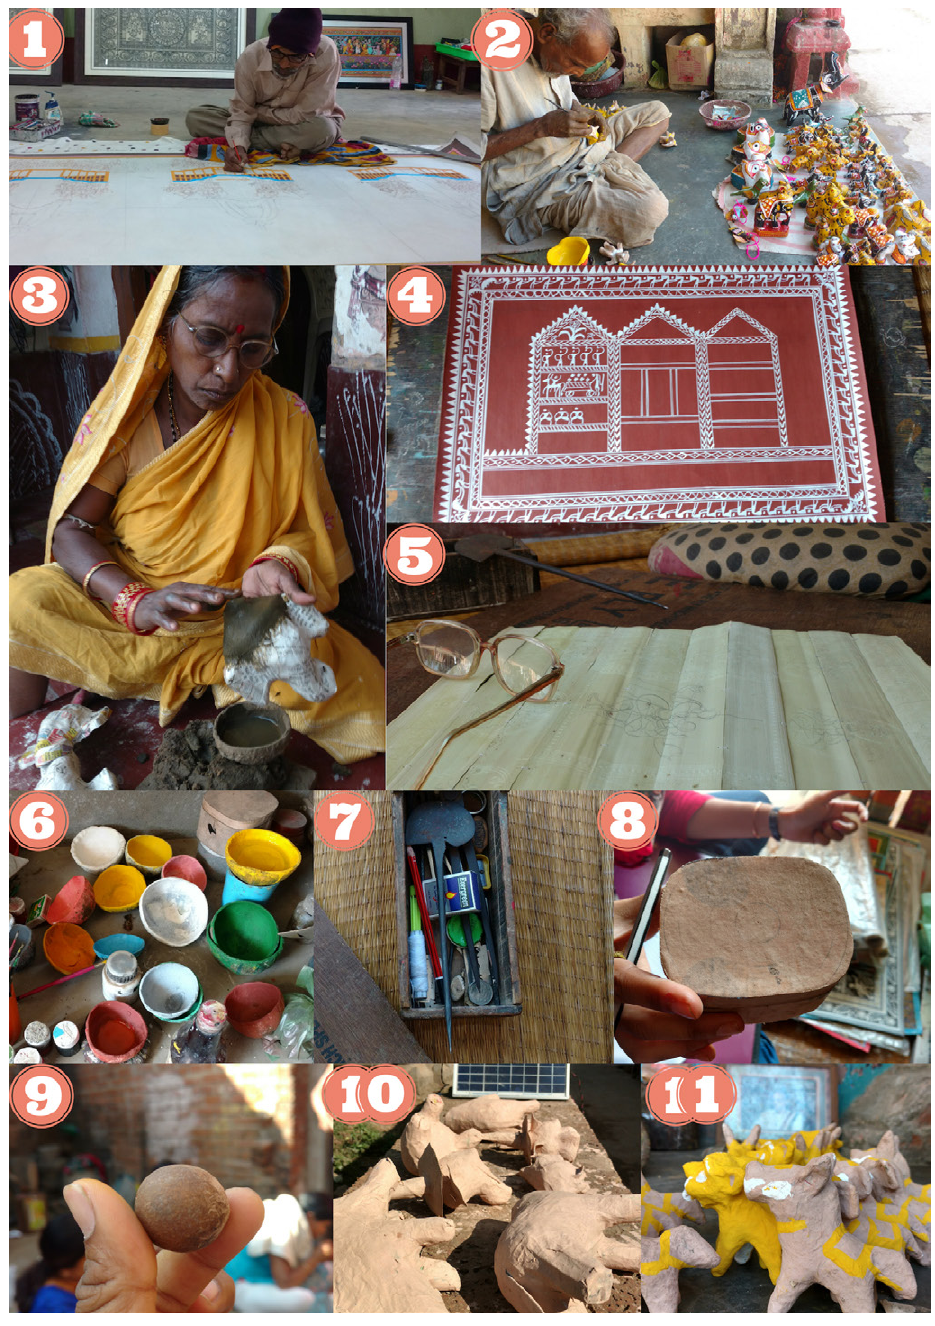
Figure 4. Collection of patta pictures in raw form (source: created by